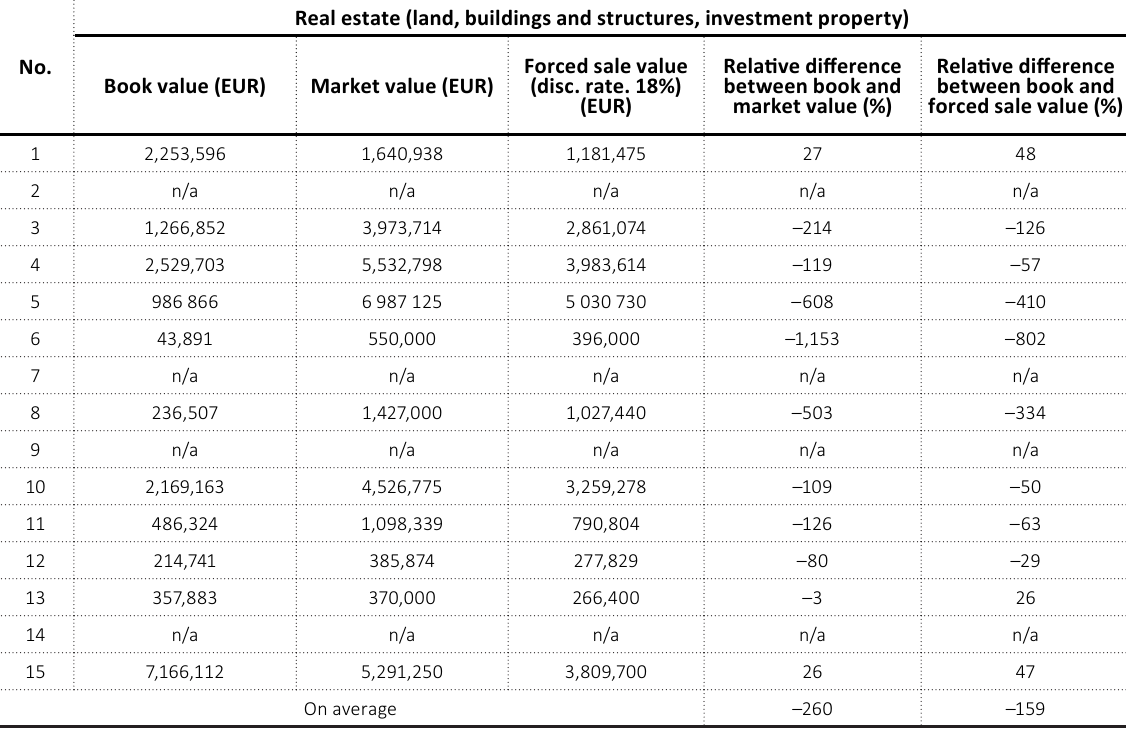
Table 3. Valuation of real estate comprising the bankruptcy estate in the examined enterprises